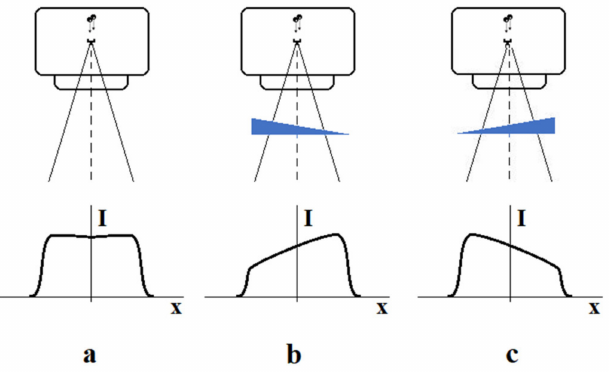
Figure 7. Influence of wedge filter on beam intensity distribution: ( a ) open field (no wedge), ( b ) left side wedge orientation, ( c ) right side wedge